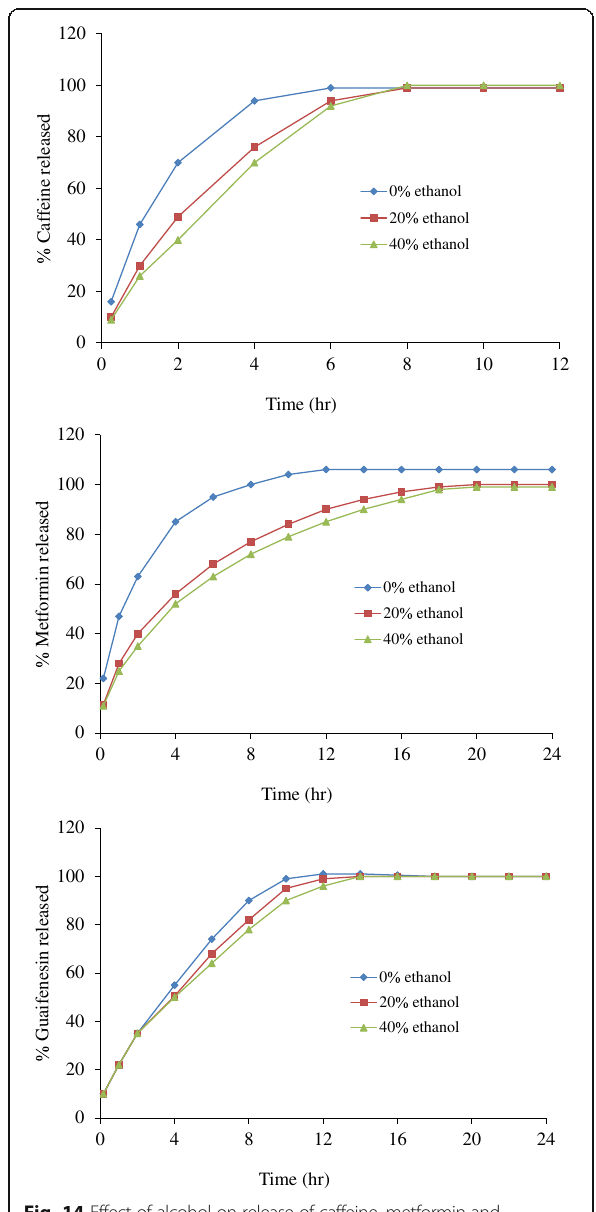
Fig. 14 Effect of alcohol on release of caffeine, metformin and guaifenesin from Carbopol 971G based tablets (data from reference ((2011) Effect of Alcohol on the Drug Dissolution Properties of Tablets Formulated with Carbopol®* Polymers, Lubrizol Technical Data